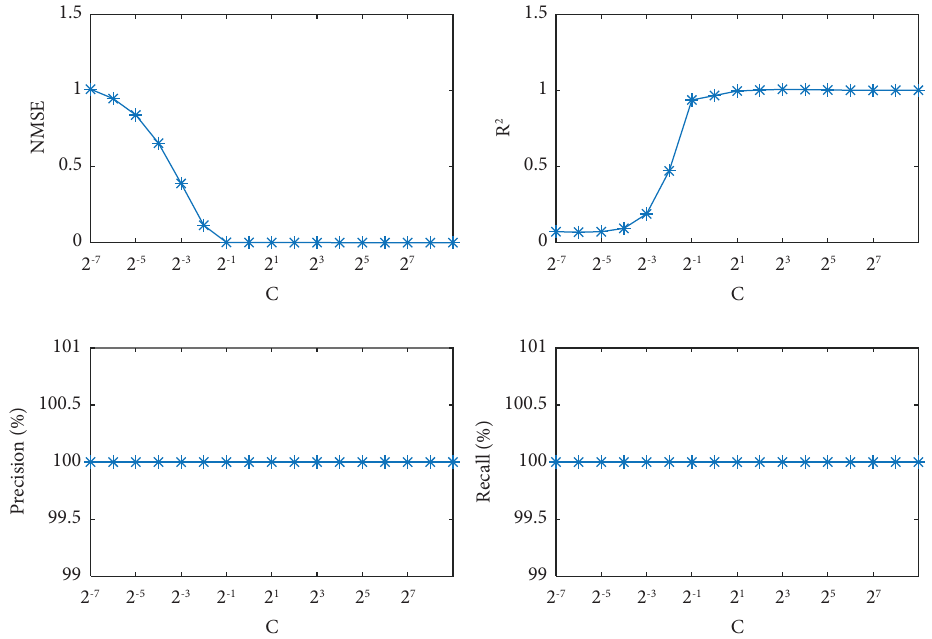
Figure 5: Te infuence of C on the NMSE, R 2 , precision, and recall for the Type B dataset. Parameter p is fxed as the optimal value.